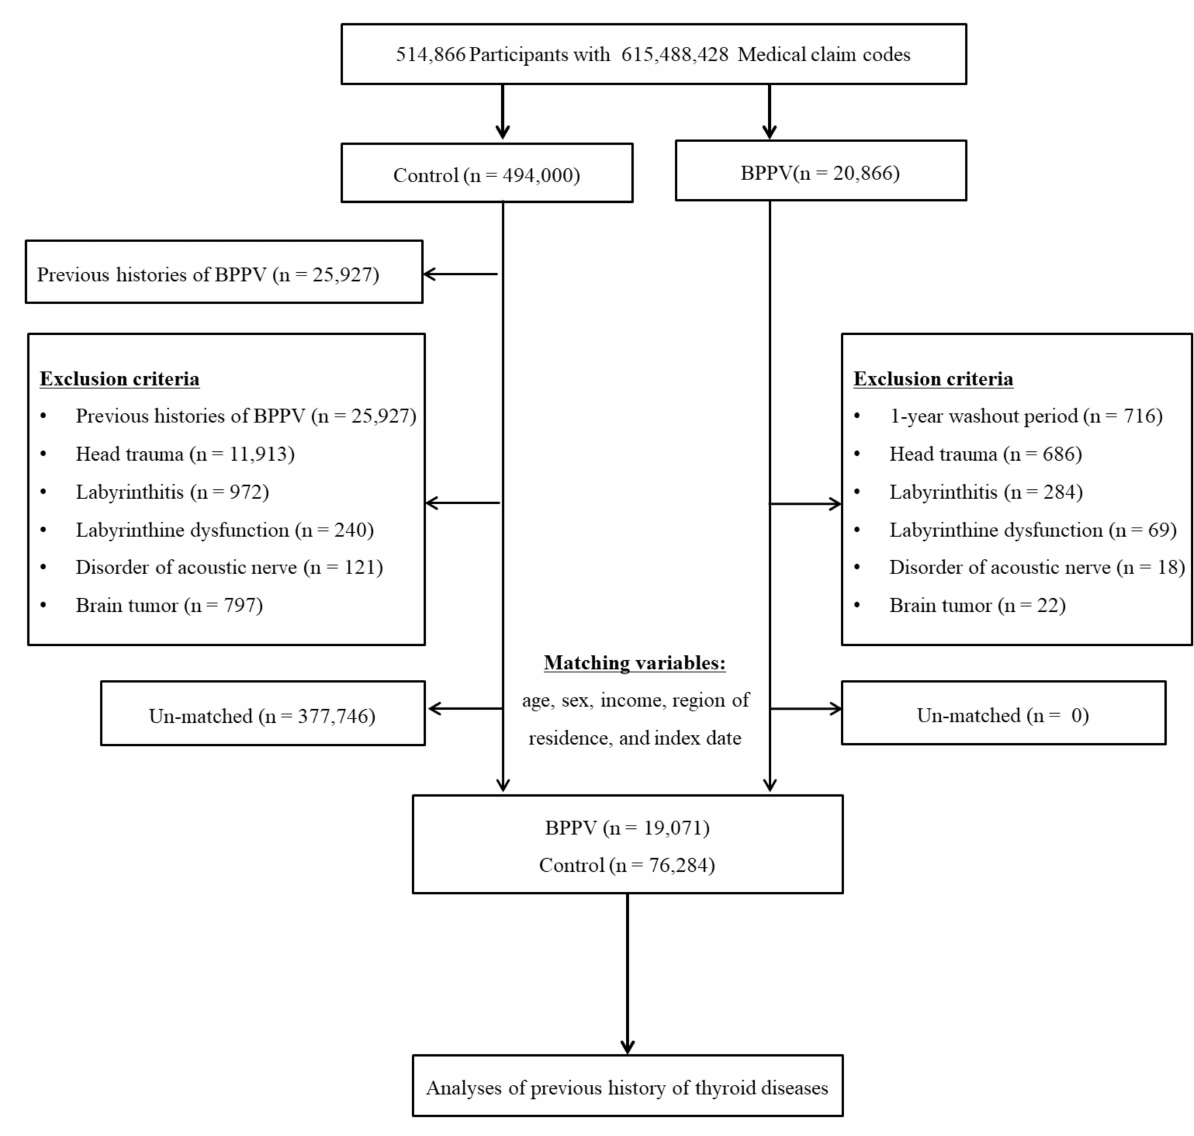
Figure 1. A schematic illustration of the participant selection process that was used in the present